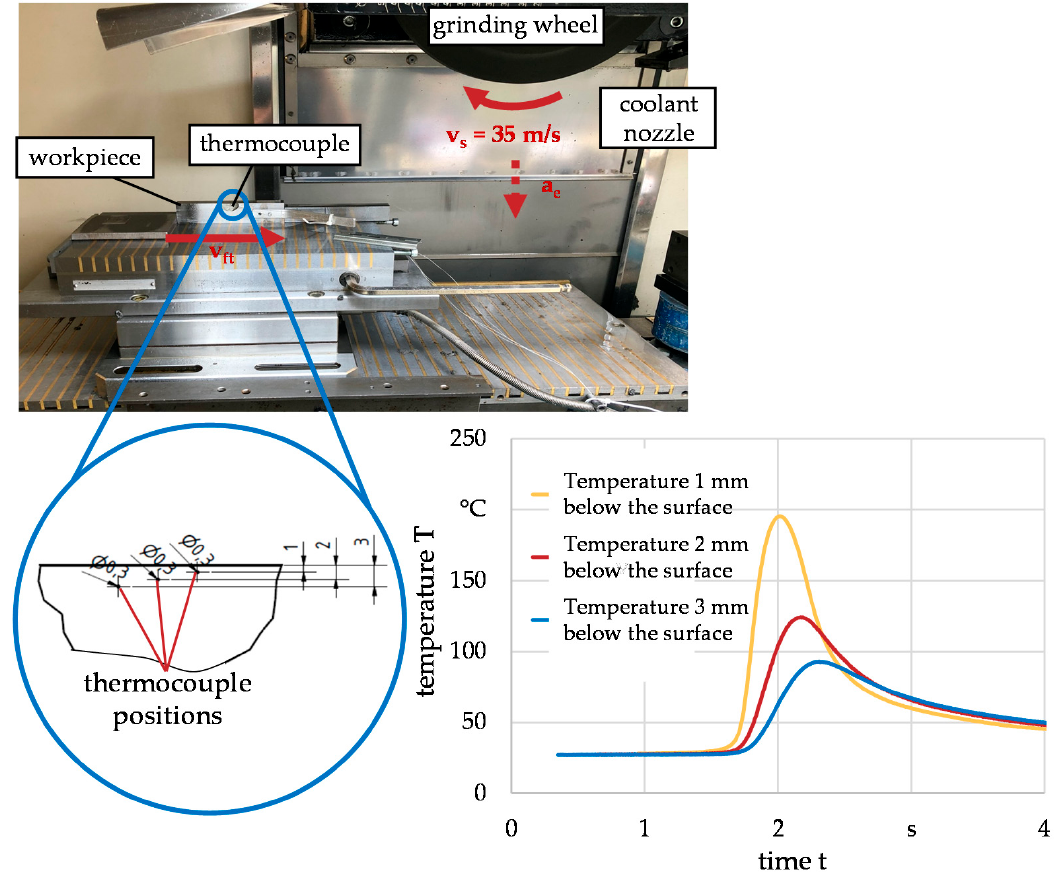
Figure 3. Experimental grinding setup in surface grinding including temperature measurements using thermocouples in different depths below the surface.